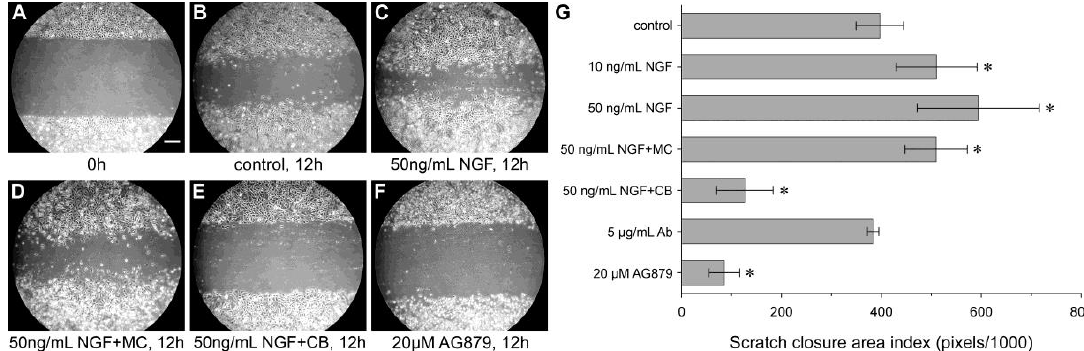
Figure 7. Effect of NGF and NGF-neutralizing agents on the migration of human oral mucosal keratinocytes. A scratch was made in confluent cultures of human oral mucosal keratinocyte monolayers. ( A ) Scratch at 0 h, scale bar 200 µm for A – F ; ( B – F ) Migration after 12 h; ( B ) No addition; ( C ) Stimulation with 50 ng/mL of recombinant human NGF. Stimulation with 50 ng/mL of NGF